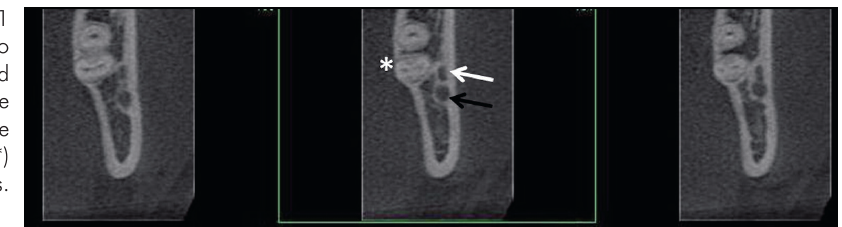
Figure 5 - Different sagittal cuts of Type 1 mandibular canal bifurcation in intimate relationship with impacted left mandibular third molars. The red lines (light gray in print version) trace the mandibular canal and its bifurcation paths.